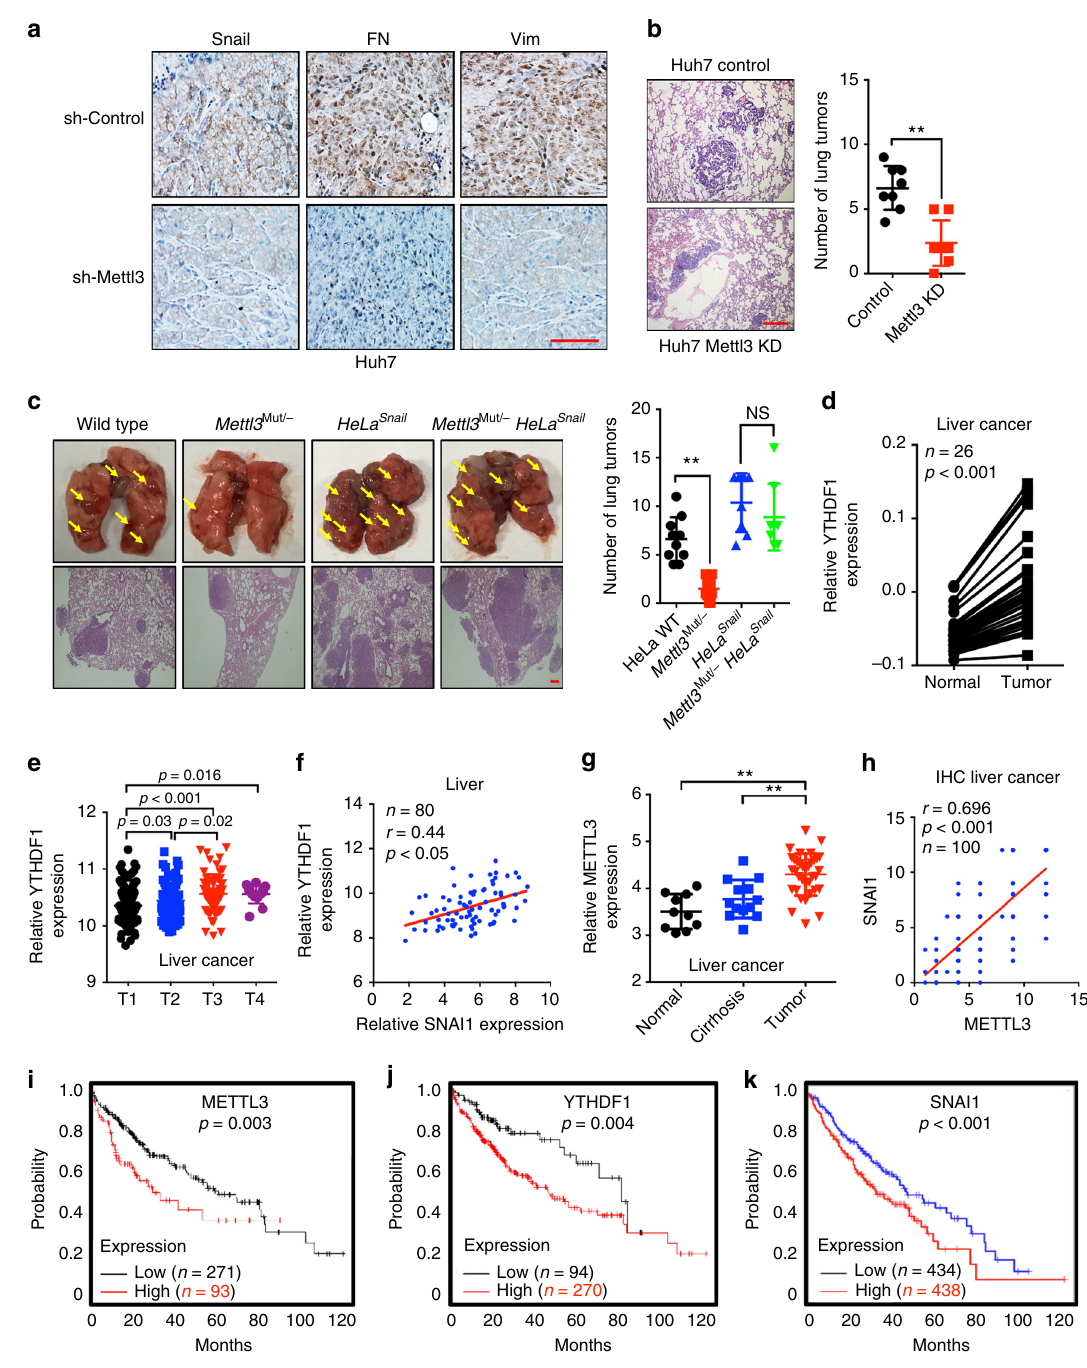
94)Expression 271)Expression Low ( n = 270)Low ( n = High ( n = High ( n = 93) Fig. 6 m 6 A methylation regulates in vivo cancer progression. a IHC (Snail, FN, and Vim)-stained paraf fi n-embedded sections obtained from sh-control and sh-Mettl3 Huh7 xenografts when the tumor volumes were about 100 mm 3 for each group. b The sh-control and sh-Mettl3 Huh7 cells were injected into the nude mice by tail vein injection. Representative images of metastatic lung tumors and the H&E staining results were shown (left), and the number of lung tumors was quantitatively analyzed (right). c HeLa WT, Mettl3 Mut/ − HeLa, HeLa Snail , and Mettl3 Mut/ − HeLa Snail stable cells were injected into the nude mice by tail vein injection. Representative images of metastatic lung tumors and the H&E staining results were shown (left), and the number of lung tumors was quantitatively analyzed (right). d Expression of YTHDF1 in paired human liver ( n = 26) cancer tissues and adjacent normal mucosa tissues from TCGA database. e YTHDF1 expression in liver cancers of T1 ( n = 153), T2 ( n = 77), T3 ( n = 65), and T4 ( n = 13) stages from TCGA database. f Correlation between YTHDF1 and SNAI1 in liver cancer patients ( n = 80) from TCGA database. g METTL3 expression in HCC tumor tissues ( n = 35), liver cirrhosis tissues ( n = 13), and normal liver tissues ( n = 10) from Oncomine database (Wurmbach liver cancers). h Correlation between Mettl3 and Snail protein in liver cancer patients (100) by use of tissue microarray (CS03 – 01 – 008, Alenabio, Xian, Shanxi, China). i , j , k Kaplan – Meier survival curves of OS based on METTL3 ( i ), YTHDF1 ( j ), or SNAI1 ( k ) mRNA expression in HCC patients. The log-rank test was used to compare differences between two groups. Data are presented as means ± SD from three independent experiments. * p < 0.05, ** p < 0.01, NS, no signi fi cant, by one-way ANOVA with Bonferroni test. Red bar = 200 μ